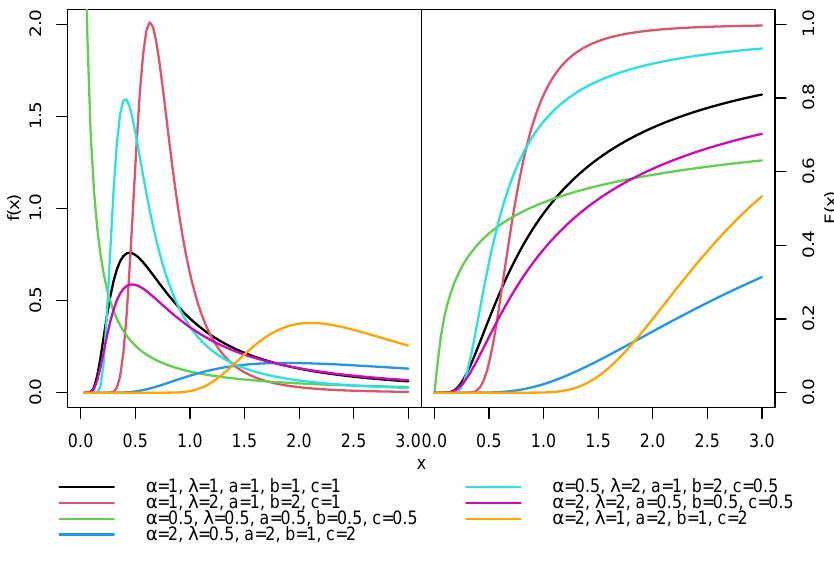
Figure 4 – PDF (left panel) and CDF (right panel) of McFrP